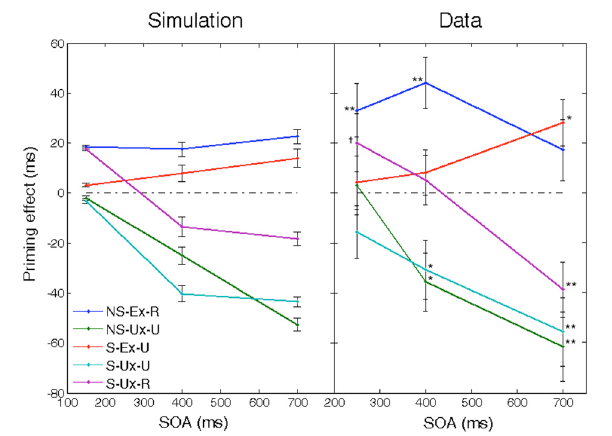
FIGURE 5 | Priming effects as a function of SOA in a simulation of Neely’s (1977) experiment, compared to the original human results. Positive values indicate facilitation and negative values indicate inhibition, relative to neutral trials. Conditions differentiated on the basis of relatedness (related vs. unrelated targets—R/U), expectancy (expected vs. unexpected targets—Ex/Ux), and whether the expected words required a shift in semantic category (shift vs. non-shift—S/NS). Significant priming effects in the human experiments are marked ( † p < 0 . 05; ∗ p < 0 . 01; ∗∗ p < 0 . 001). Error bars represent ± 1 standard error of the means. Data of human subjects were taken from Neely (1977). See text for